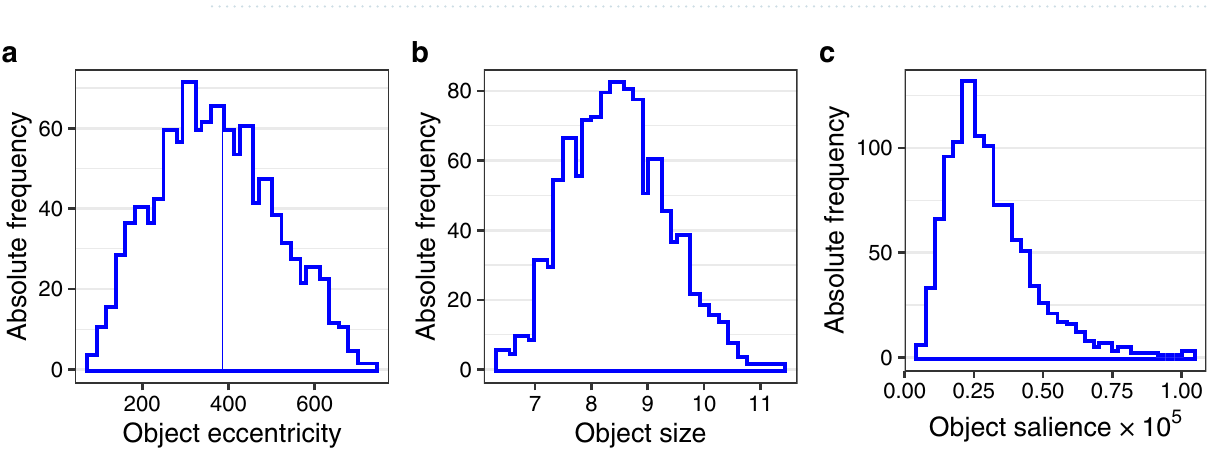
Figure 3. Distribution of object properties; ( a ) object eccentricity, ( b ) object size and ( c ) object